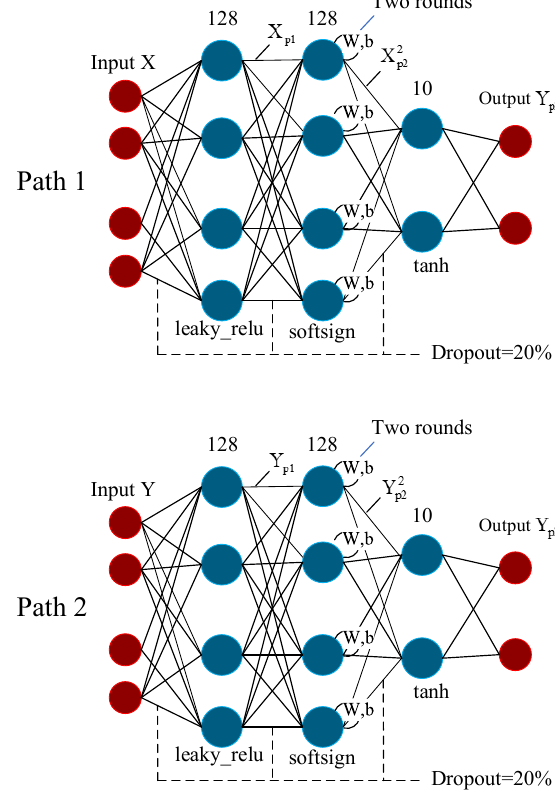
Figure 2. Structure of proposed Dual-path Partial Recurrent Networks (D-PRNs).